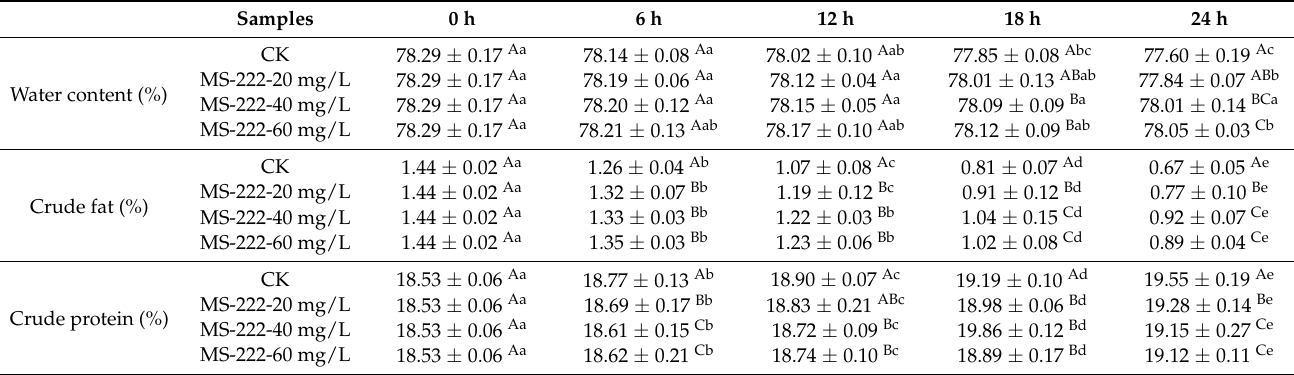
Table 2. The effect of simulated transport stress on the chemical composition of turbot flesh. Samples